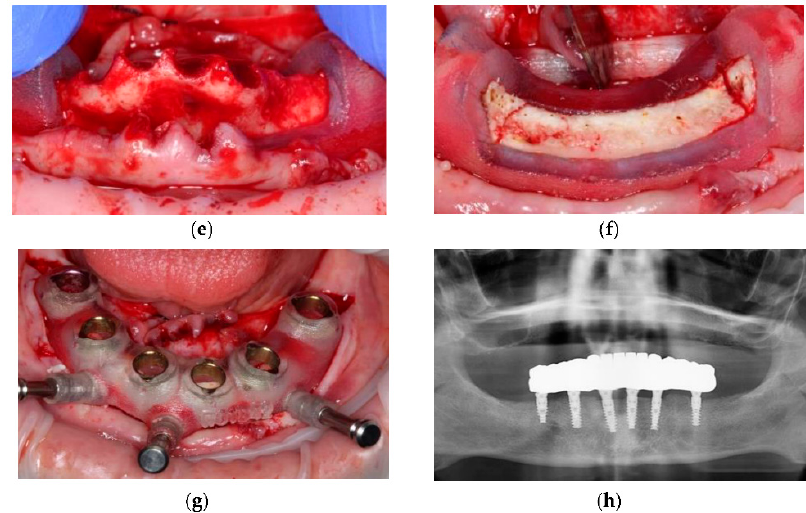
Figure 2. Example of a case using bone reduction guide: ( a ) Pretreatment clinical situation. Frontal view of mandibular arch; ( b ) Scans of the initial clinical situation of the patient. Horizontal arrow shows the bone level after extraction, vertical arrow shows the desired bone level after reduction; ( c ) Computerized virtual mandibular alveolar bone reduction surgical guide and the bone level after reduction; ( d ) Computerized virtual for implant position after bone reduction; ( e ) Acrylic resin bone reduction surgical guide in position after tooth extractions, prior to bone reduction; ( f ) Alveolar ridge reduction according to virtual plan and surgical guide; ( g ) Second surgical guide used to insert dental implants according to pretreatment virtual plan. Anchoring pins secured guide in the right position after bone reduction; ( h ) Post-operative panoramic radiograph of implants and definitive prosthesis.